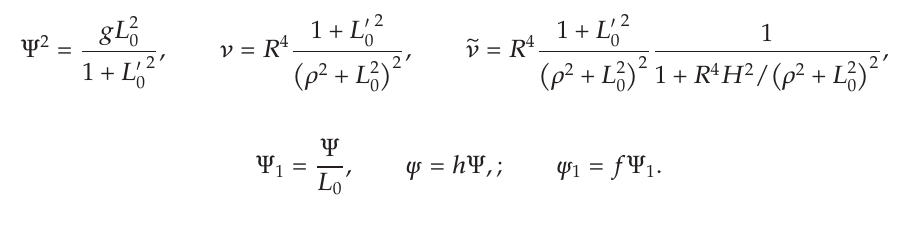
Figure 6: There is a characteristic